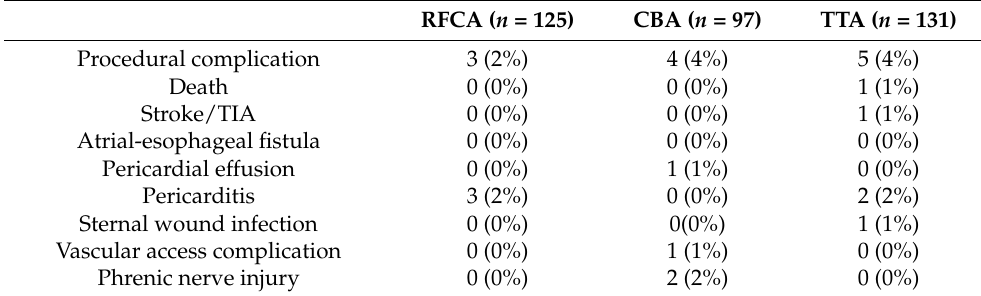
Table 5. Procedure-related